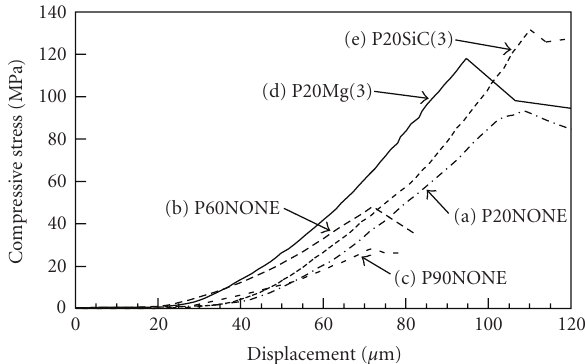
Figure 8: Variations in displacement-compressive stress curves of (a) P20NONE, (b) P60NONE, (c) P90NONE, (d) P20MgO(3), and (e) P20SiC(3).